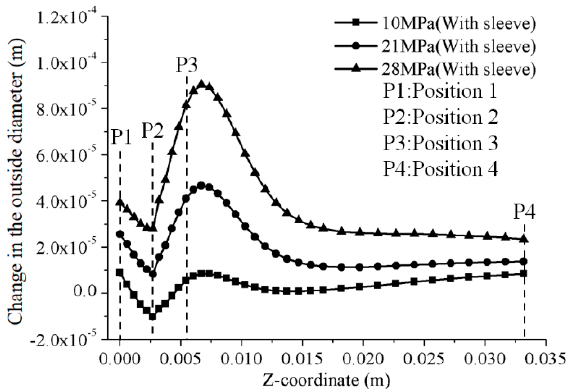
Figure 7. The ratcheting strain distribution between Position 1 and Position 4 under different internal pressures after 45 cycles.